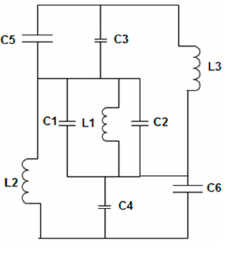
Figure 4. Equivalent LC circuit model of the proposed unit cell.